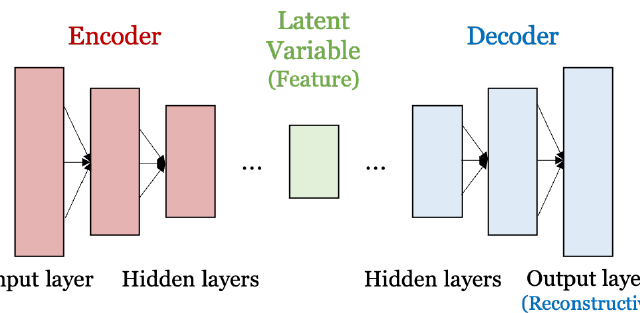
Figure 1. Structure of the